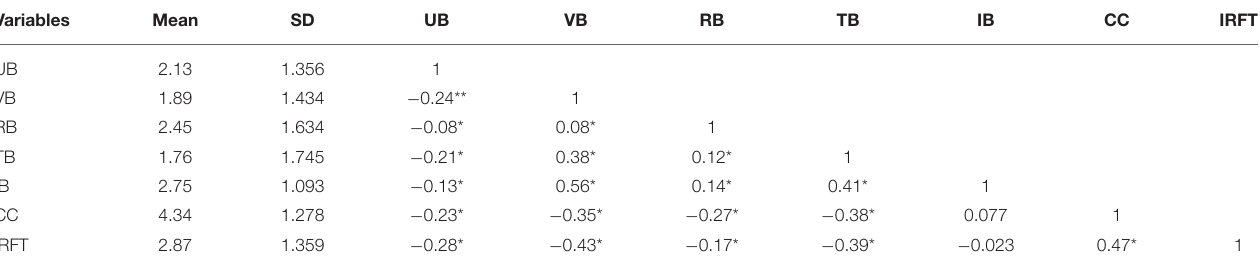
TABLE 1 | Descriptive statistics.